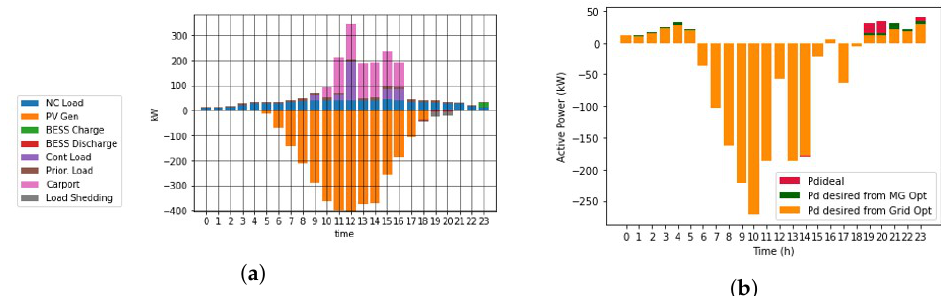
Figure 11. Proposed dispatch for the microgrid in the first iteration of the hierarchical model.